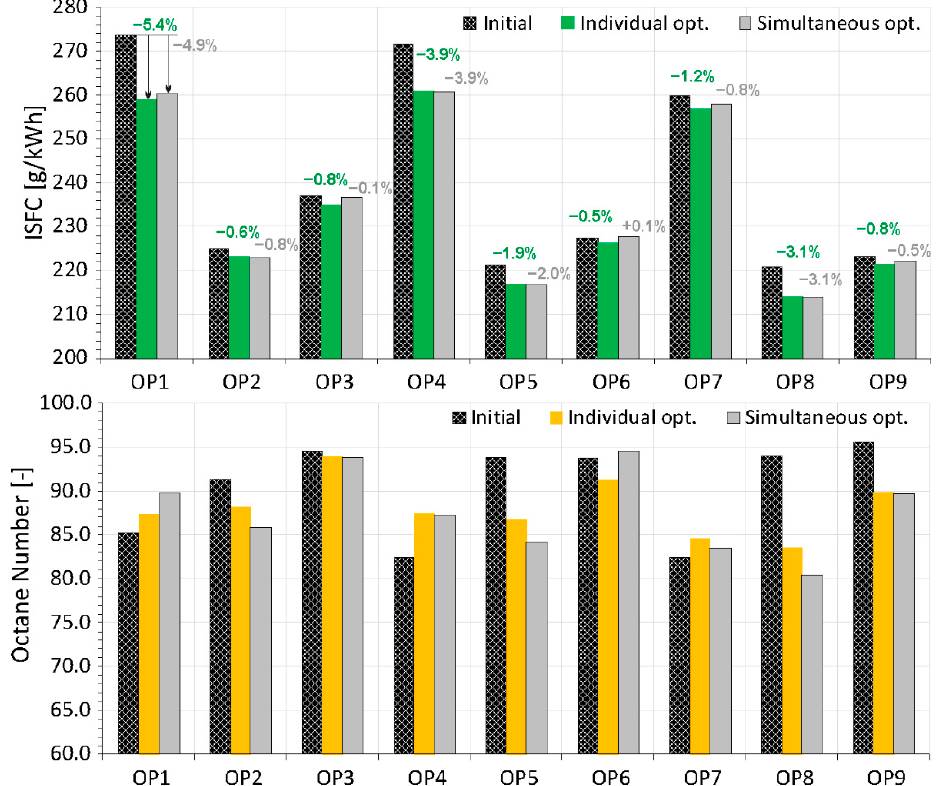
Figure 16. Comparisons of ISFC and ON (initial vs. optimized result) over optimization points for individual and simultaneous